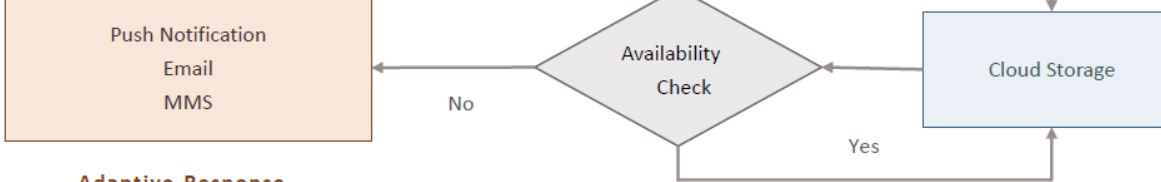
Figure 1. System Architecture of IHAS.